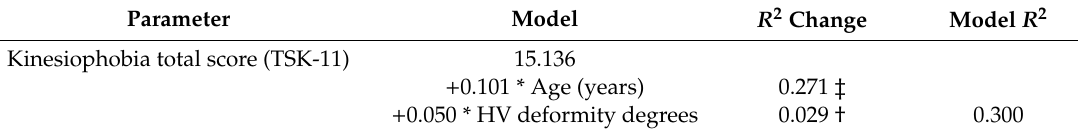
Linear regression model for the kinesiophobia total score multivariate among HV deformity